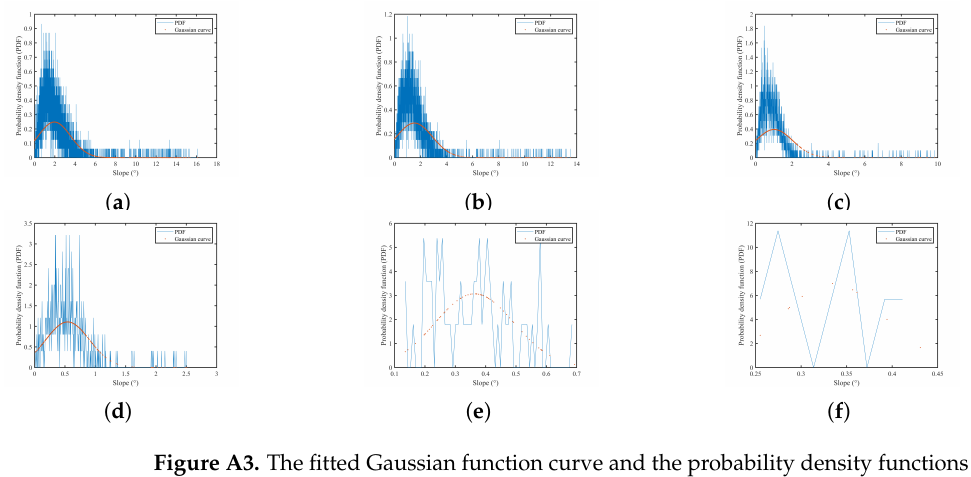
Figure A3. The fitted Gaussian function curve and the probability density functions of the six groups of scale terrain slope: ( a ) 100 × 100 pixels, ( b ) 75 × 75 pixels, ( c ) 50 × 50 pixels, ( d ) 25 × 25 pixels, ( e ) 10 × 10 pixels, ( f ) 5 × 5